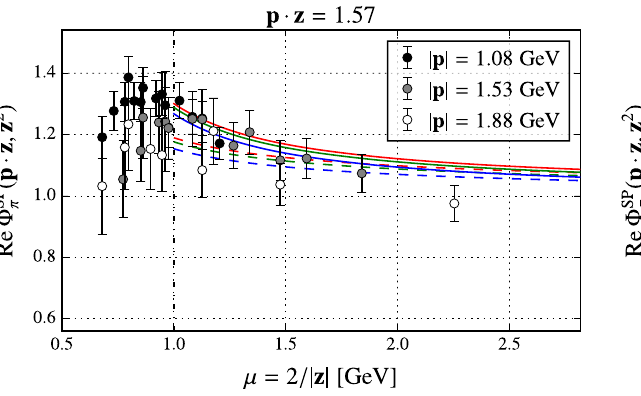
Fig. 6 The plots show our results for the scalar-pseudoscalar channel for different fixed values of p · z and different pion momenta. The error- bars include the statistical error only. The solid/dashed lines correspond